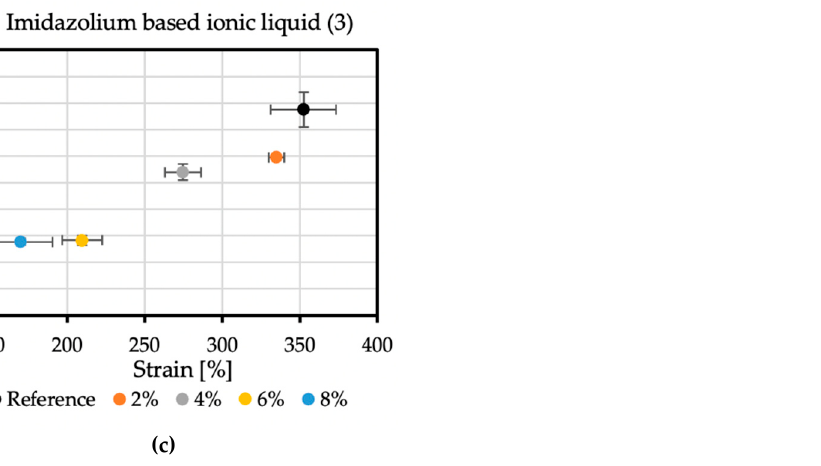
Figure 6. Mechanical properties of samples with ( a ) no. 1 additive, ( b ) no. 2 additive, and ( c ) no. 3 additive.